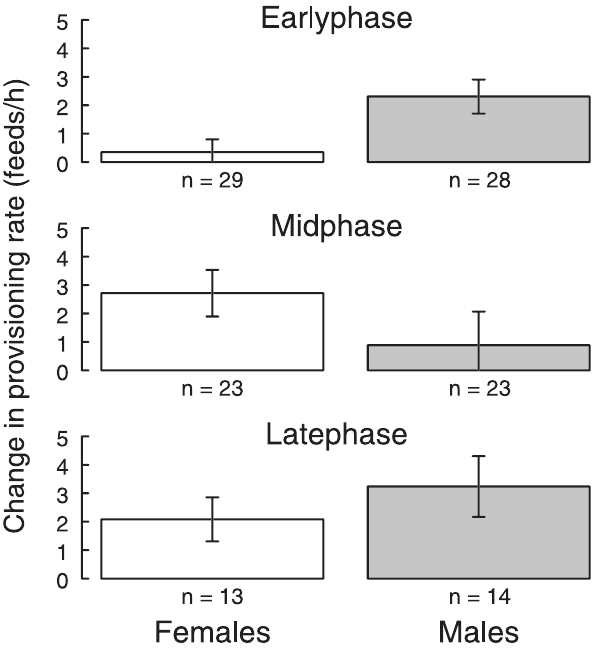
Figure 3. The mean response of partners to an increase in focal bird provisioning rate at each nestling stage. Values are from the raw data. Sample size and SE are indicated.